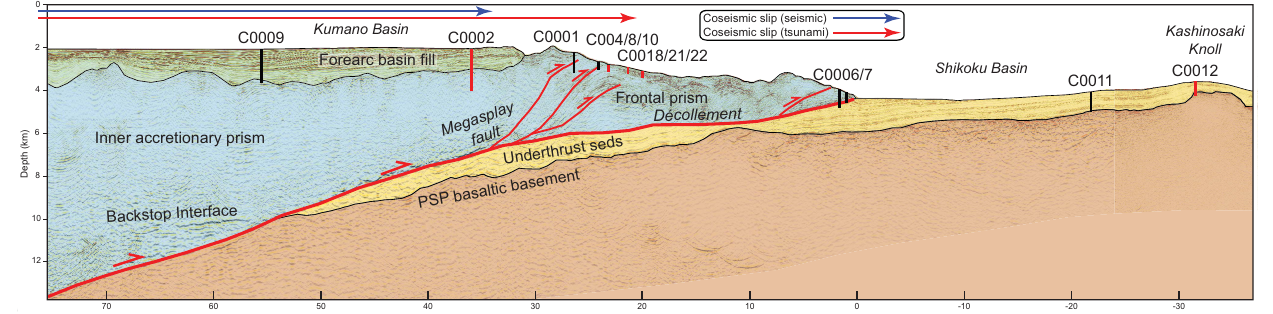
Figure 2. Regional 2-D seismic line showing Expedition 338 sites (red) in relation to NanTroSEIZE Stage 1 and 2 sites (black). PSP = Philippine Sea Plate. Lines at top with arrows indicate seaward distribution of coseismic slips 1944 and 1946 earthquakes estimated from tsunami inversion (red; Tanioka and Satake, 2001) and seismic waveform inversion (blue; Ichinose et al., 2003; Kikuchi et al., 2003). Location shown in Fig. 1. Modified from Park et al. (2002, 2008) and Nakanishi et al. (2008).